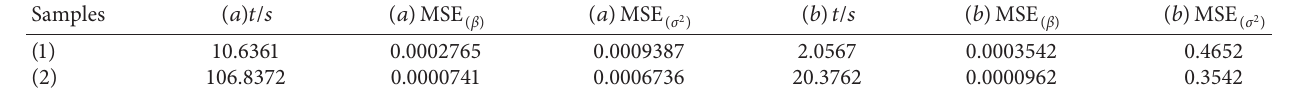
Table 1: Computational time and estimation accuracy of the two algorithms in scenario (1). Samples